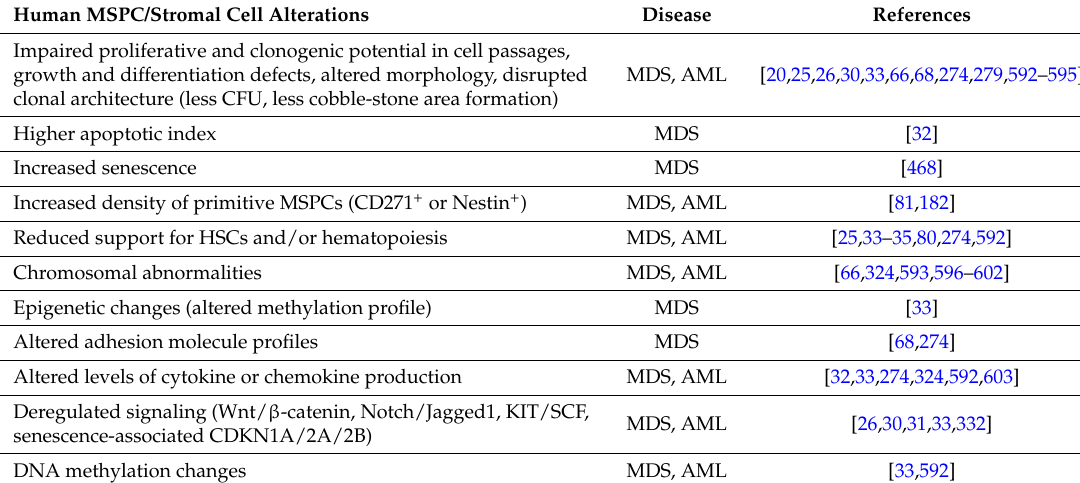
Table 3. Human MSPC alterations in MDS and